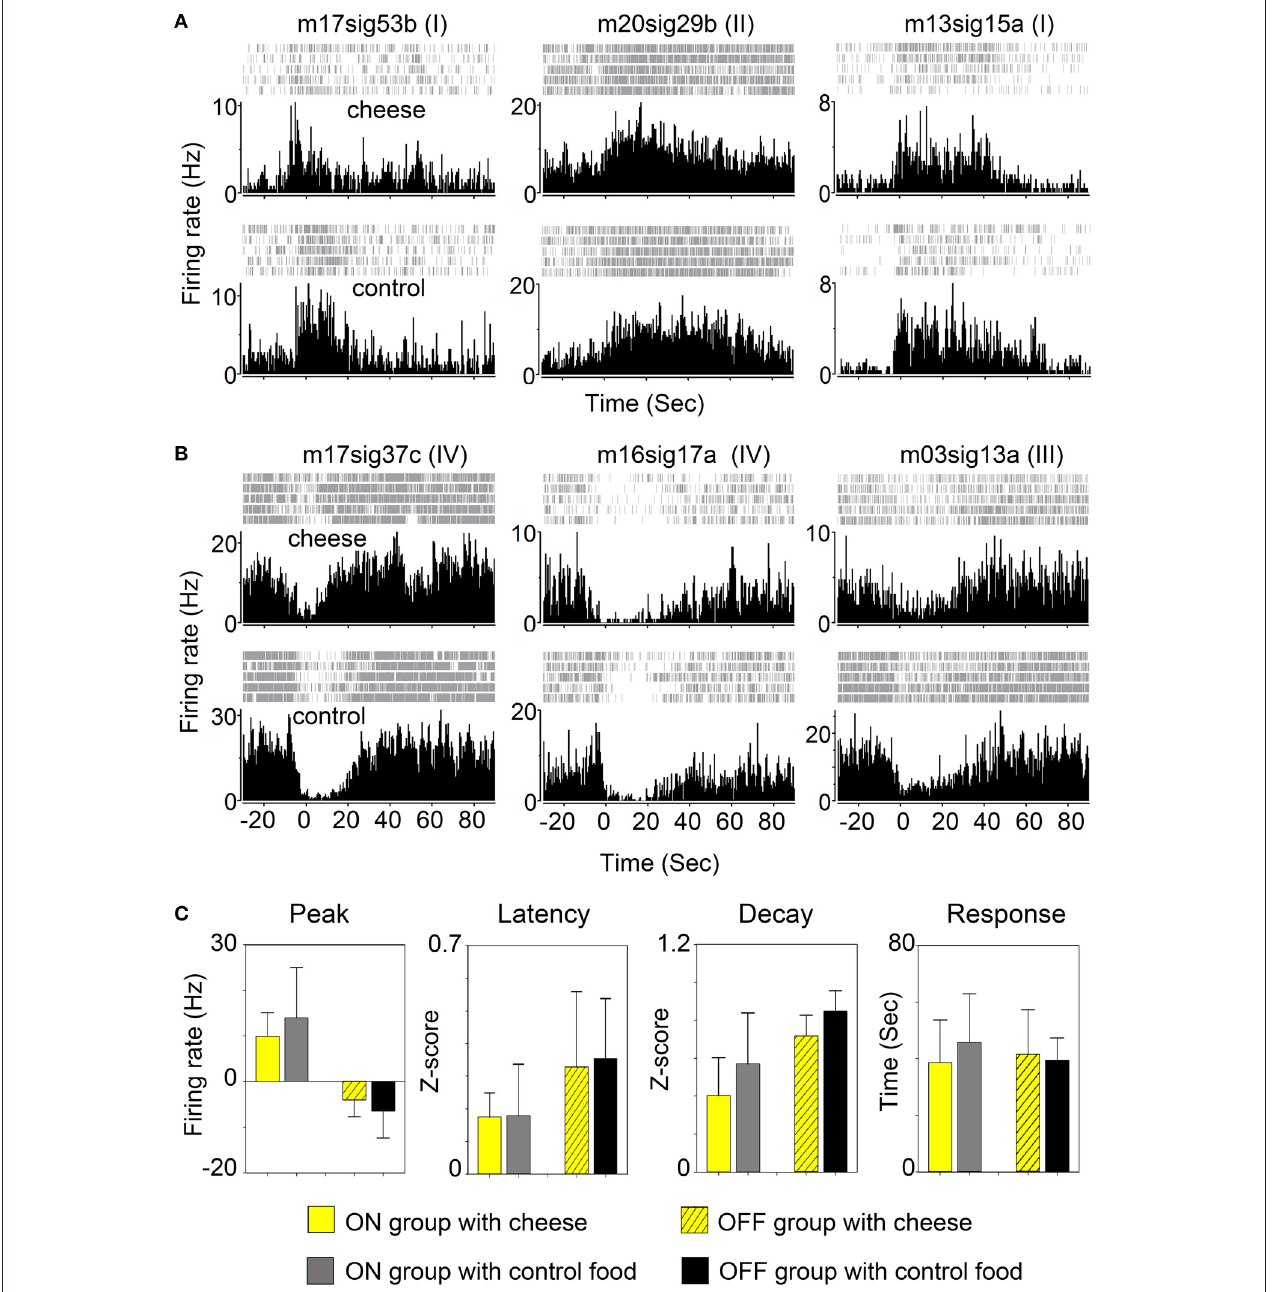
FIGURE 4 | Response of FRNs to distinct food type. (A) Three “ON” group FRNs in cheese test (top panels) and control chow food test (bottom panels). (B) Three “OFF” group FRNs in cheese test (top panels) and control chow food test (bottom panels). (C) Statistical data showed the variations of peak response, peak latency, peak decay and firing duration between cheese and chow food in both ON group ( n = 9 neurons, N = 6 mice) and OFF group ( n = 7 neurons, N = 6 mice). No significant difference among any parameter in each group was